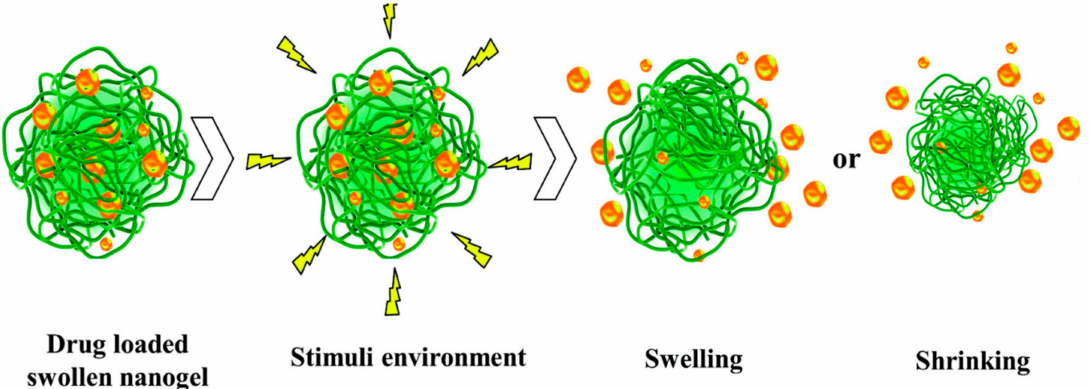
Figure 3. Drug release from a nanogel network under stimuli environments. The swelling or shrinking process of nanogel under stimuli environment to attain the controlled release. Adapted from [44] Copyright (2017) Taylor and